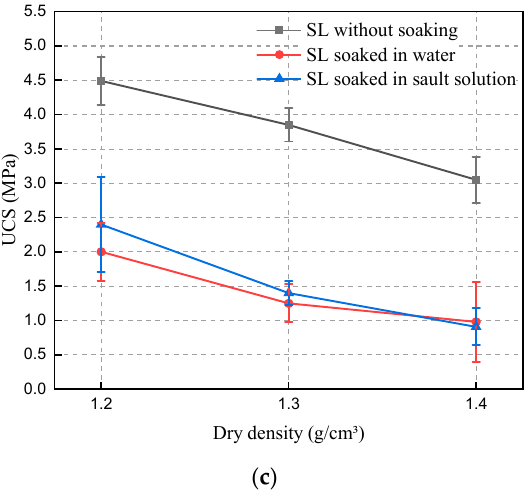
Figure 7. The effect of the service environments on compressive strength. ( a ) 5% water content, ( b ) 10% water content, ( c ) 15% water content.